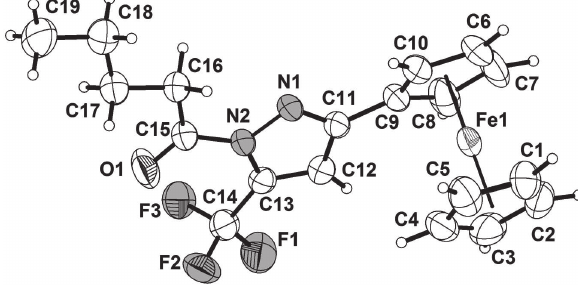
Table 1: Data collection and handling.